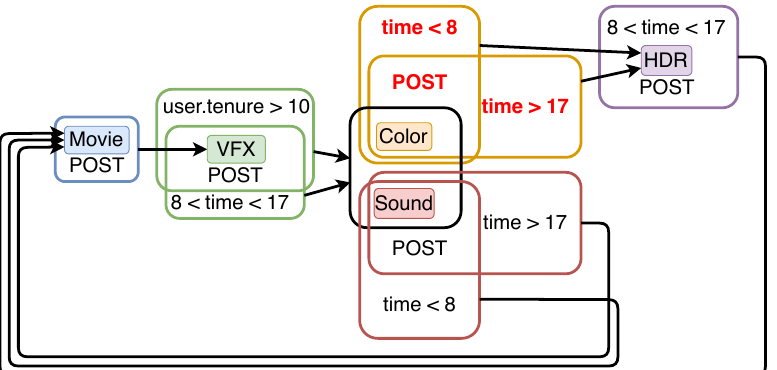
Figure 13. Specification metagraph. Elements of the variable set are identified by filled rectangles, and nodes of the metagraph by unfilled rectangles. Propositions being on the edges or in the invertices are equivalent when dealing with conditional